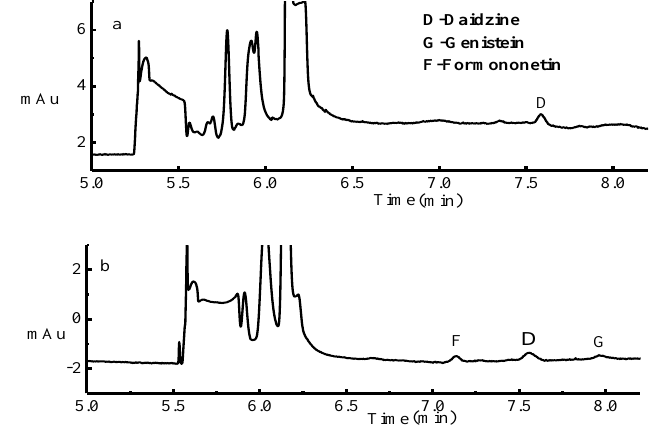
Figure 4. Electropherograms of ( a ) coffee sample; ( b ) coffee sample spiked with 1.0 µg/mL three isoflavones.